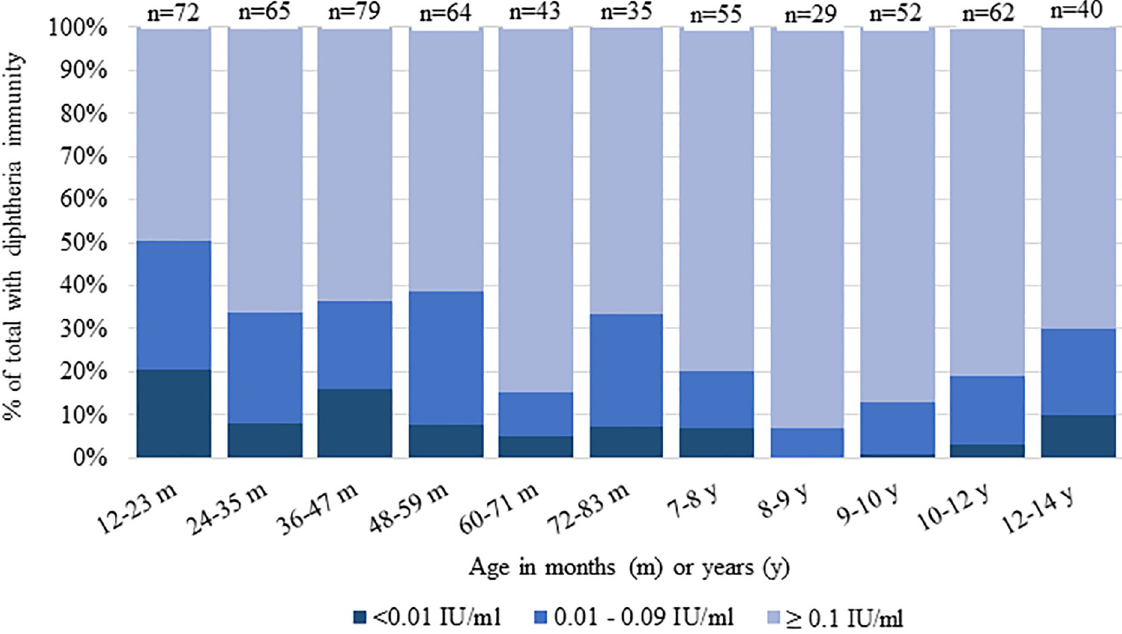
Fig 3. Diphtheria antibody levels in the MSs by age category, serologic and vaccination coverage survey among Rohingya children, Cox’s Bazar, Bangladesh, 2018. IU, international units; MS, makeshift settlement.